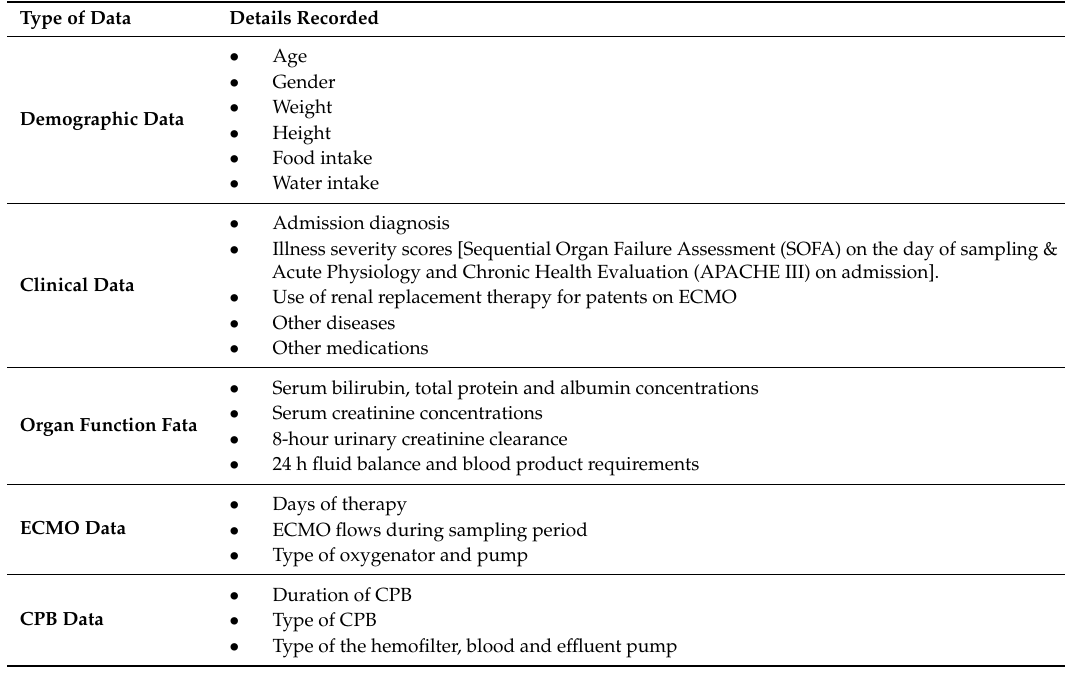
Table 1. Data collection and management.